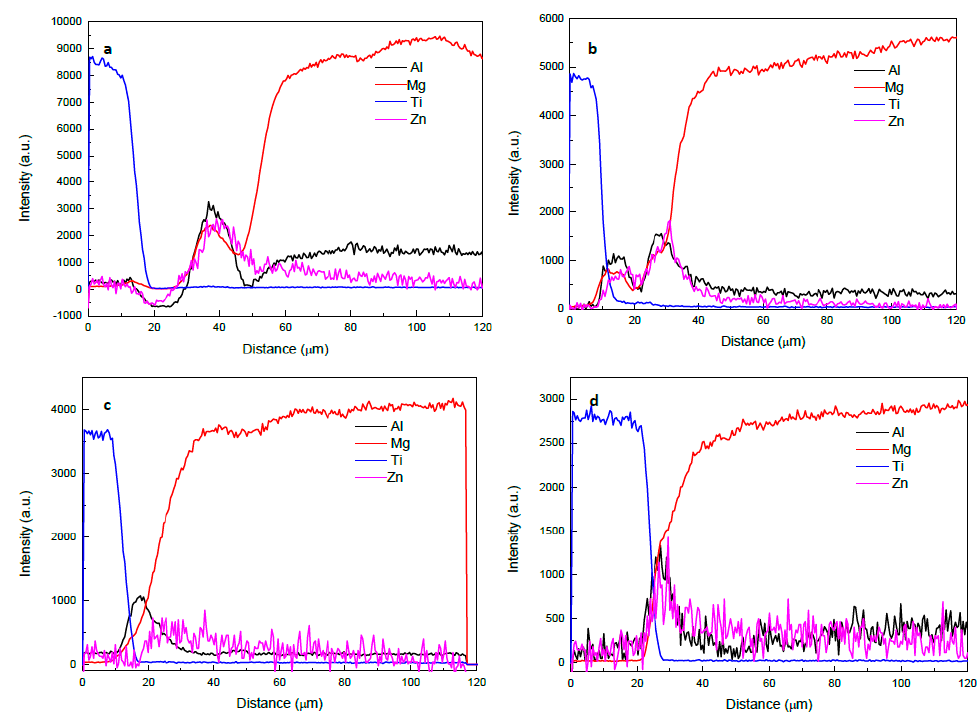
Figure 4. EDS line scans of Mg, Ti, Zn, and Al across the joint region for bonds made at ( a ) 5, ( b ) 15, ( c ) 20, and ( d ) 30 min.